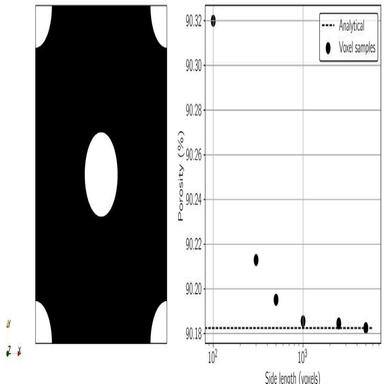
Thermal conductivity for the square array of cylinders with different resolutions.